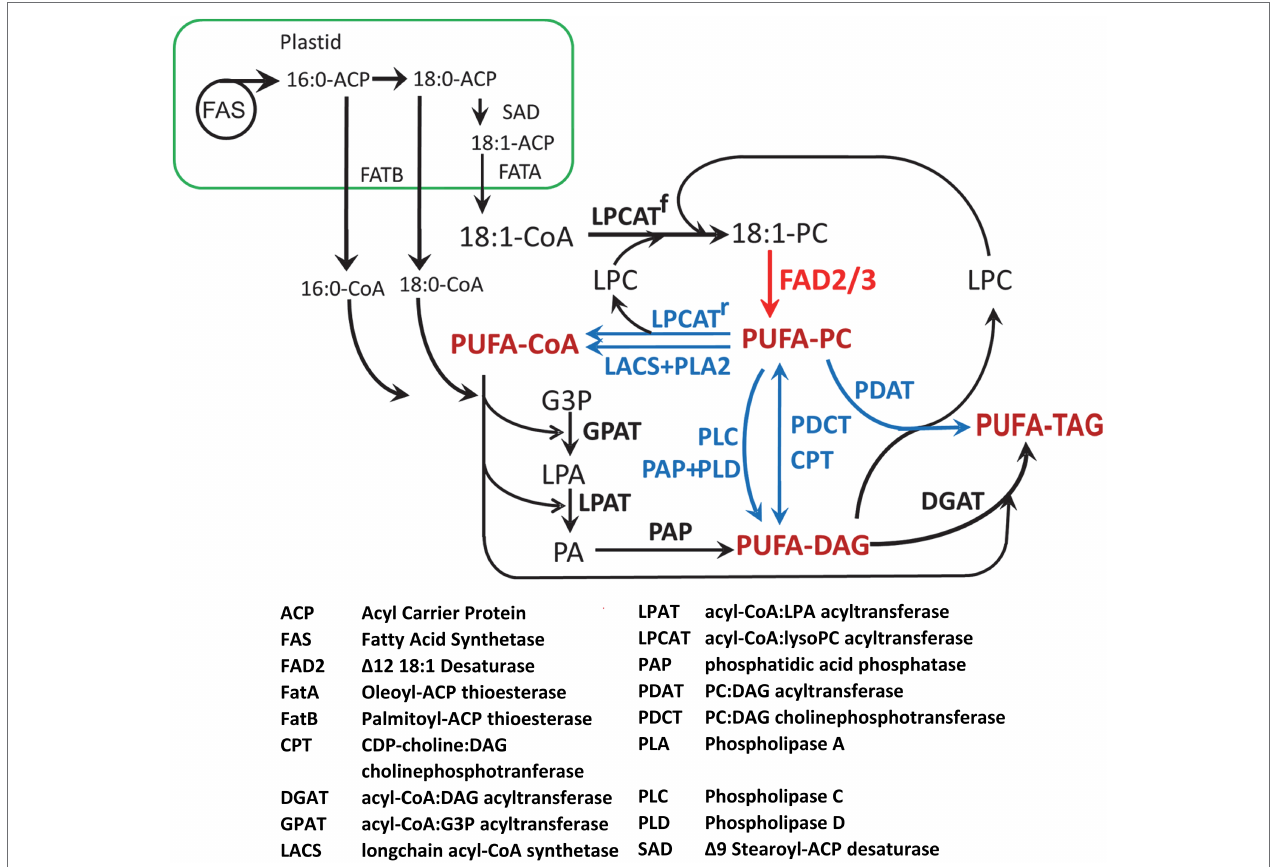
FIGURE 2 | A simplified metabolic scheme for the synthesis of fatty acids and TAG in oilseeds. Following synthesis in the plastid, 16:0, 18:0, and 18:1 are exported to the cytoplasm and edoplasmic reticulum as acyl-CoAs. Saturated 16:0 and 18:0 are mainly incorporated through GPAT of the Kennedy pathway. Monounsaturated 18:1 may also enter the Kennedy pathway, but most is incorporated directly into PC by LPCAT. PUFA are synthesized from 18:1 on PC by the FAD2 desaturase, with some being further desaturated by FAD3 (red arrow). The three pathways that can mobilize PUFA from PC for TAG synthesis, shown in blue, are: (1) removal of PUFA from PC to the acyl-CoA pool by reverse LPCAT or combined PLA2 and LACS; (2) removal of the PC phosphocholine head group to produce PUFA-DAG by PDCT, reverse CPT, PLC, or PLD/PAP; (3) direct transfer to DAG by PDAT. Substrate abbreviations are as follows: DAG, diacylglycerol; G3P, glycerol-3-phosphate; LPA, lyso-phosphatidic acid; LPC, lyso-phosphatidylcholine; PA, phosphatidic acid; PC, phosphatidylcholine; TAG,